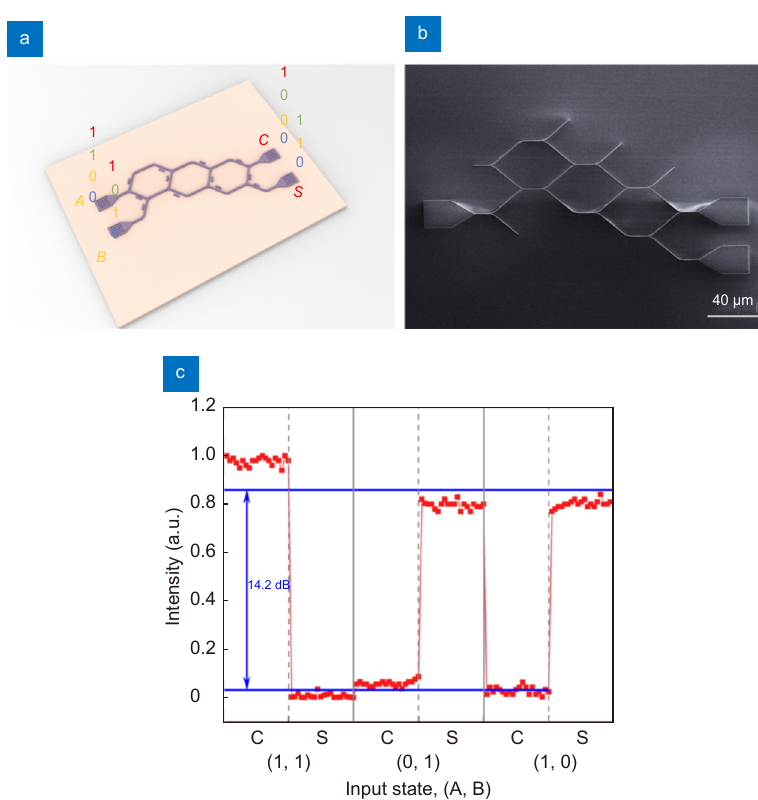
Fig. 5 | Half-adder. ( a ) Schematic diagram of the half-adder. Ports A , B are the signal inputs, and C and S represent the Carry and the Sum bit, respectively. ( b ) Top-view SEM image of the half-adder. ( c ) Intensity distribution of Sum bit and Carry bit corresponding to three different input signals in the half-adder. The blue lines give the average intensity values of the 0 and 1 logic